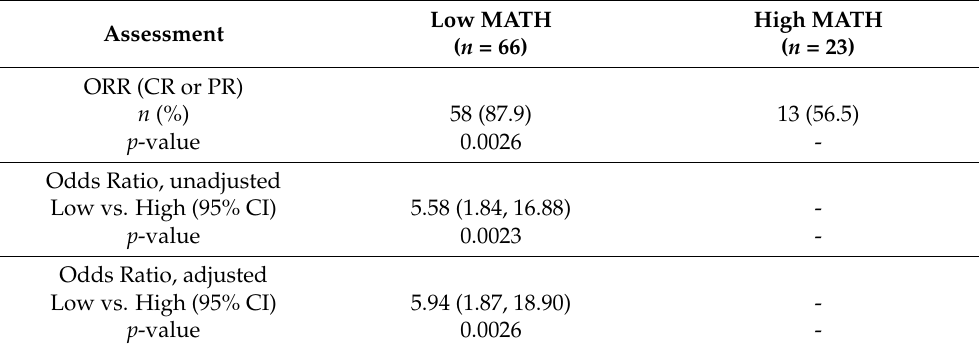
Table 5. Objective response rate by post-induction MATH category. Clinical factors for adjustment included treatment arm and liver resection during first line.